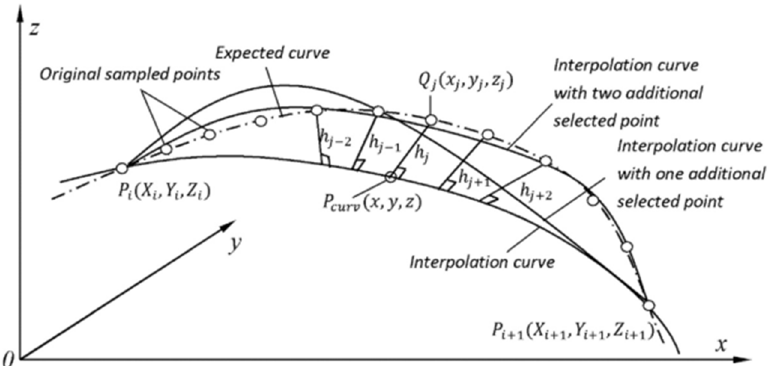
Figure 4. Schematic diagram of point cloud data extraction method with permission from [47], 2016, Elsevier.